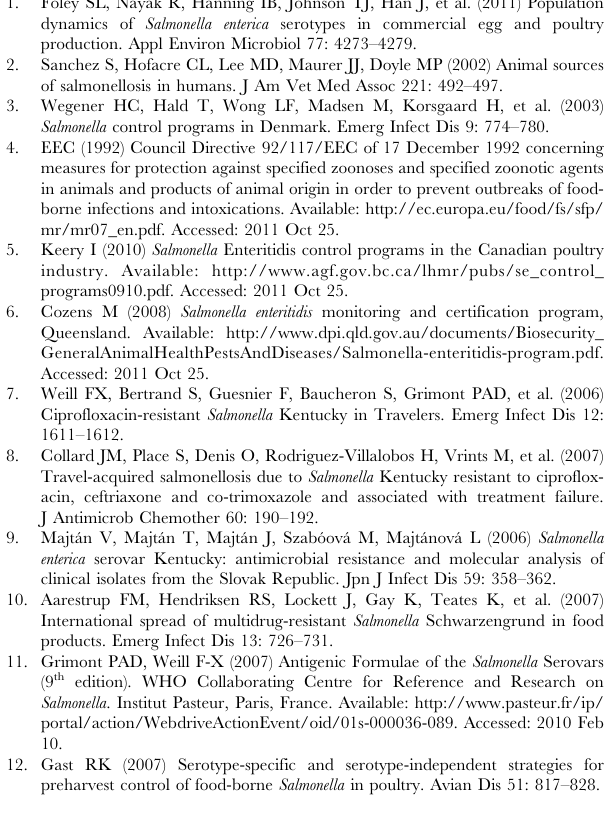
Figure 2. Dendrogram showing the cluster analysis on the basis of Xba I-PFGE of the 30 Salmonella Kentucky and 30 non-serotyped isolates obtained from commercial layer poultry farms in Bangladesh, 2009–2010. Dice coefficient was used to perform similarity analysis, and clustering was performed by using unweighted pair-group method with arithmetic means (UPGMA) with 1% band position tolerance and 0.5% optimization parameter. KT, S. Kentucky; NT,